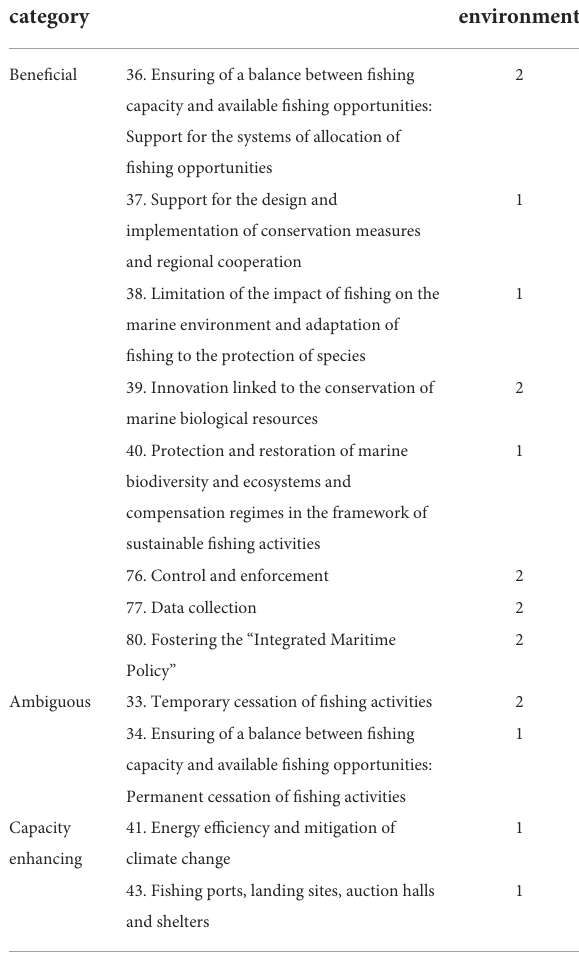
TABLE 1 Bridging table between the list of operations and the variables included in the aggregated database. Data field from list of